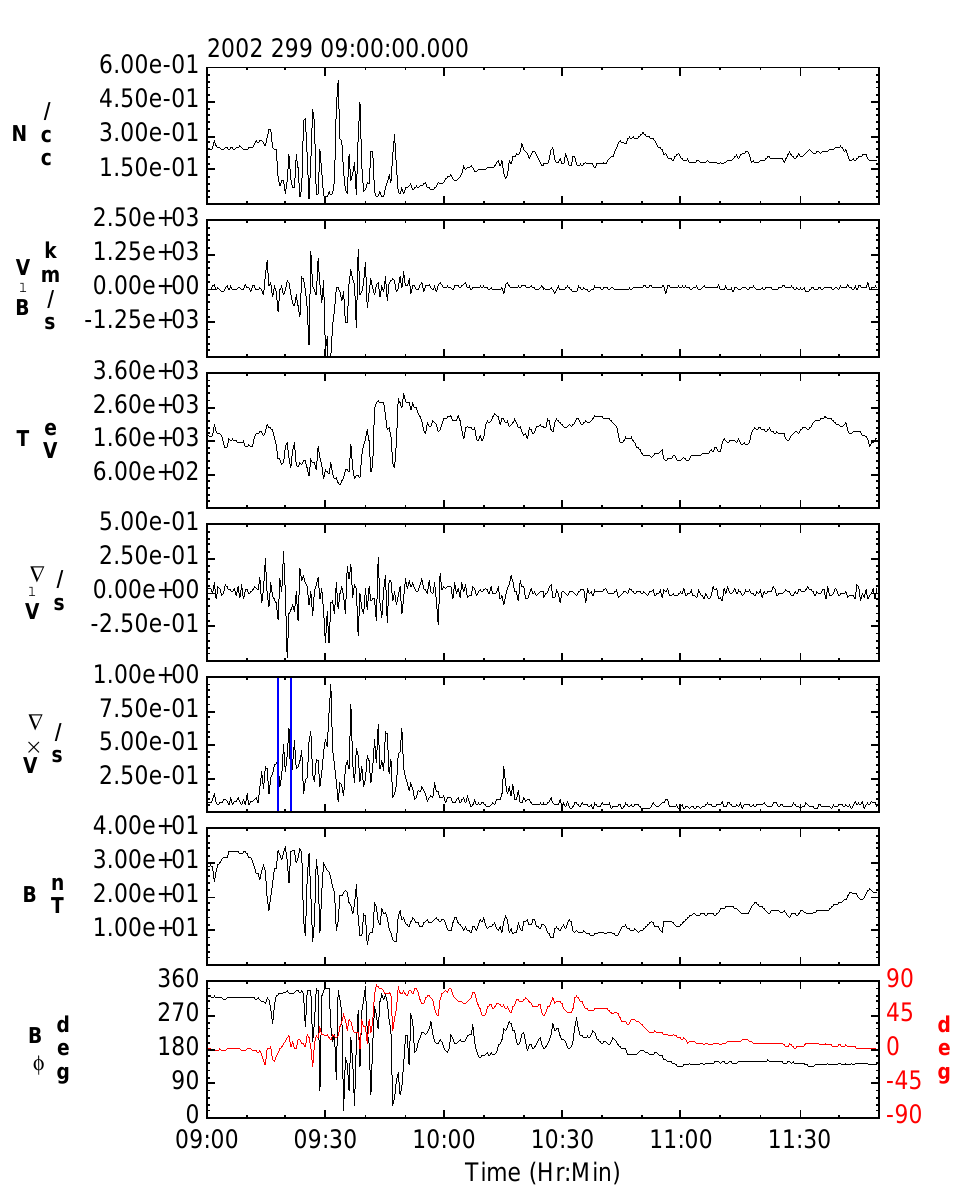
Fig. 2. Overview of tail crossing on 17 October 2002 (Event 4) using the same format as in Fig. 1. Again, with the exception of the divergence and vorticity, which use all four spacecraft, the data shown were obtained from